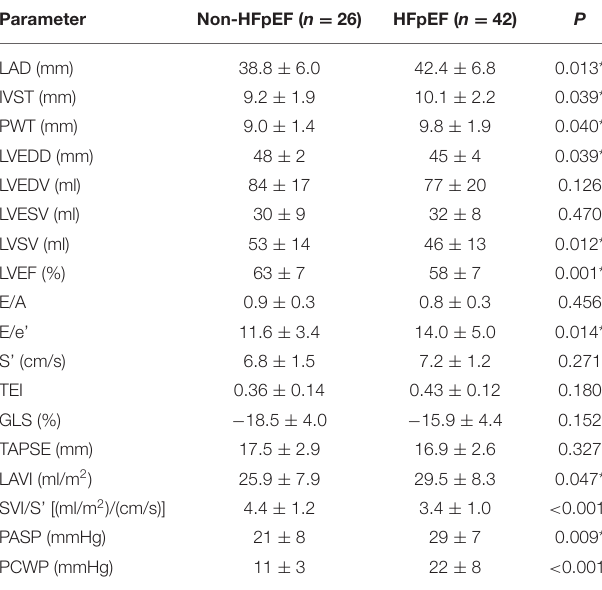
TABLE 4 | Correlations between parameters and